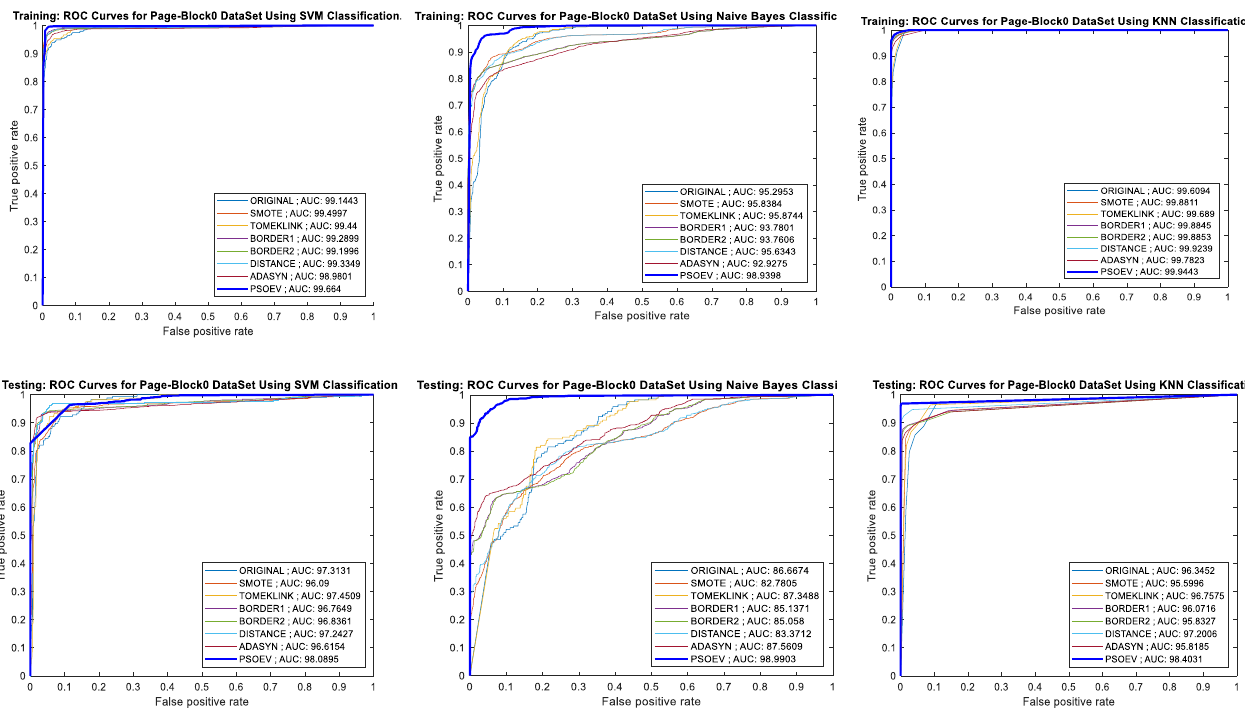
Figure 12. AUC-ROC curves of training and testing of PageBlocks0 dataset using SVM, NB, and k - NN classification methods, respectively.